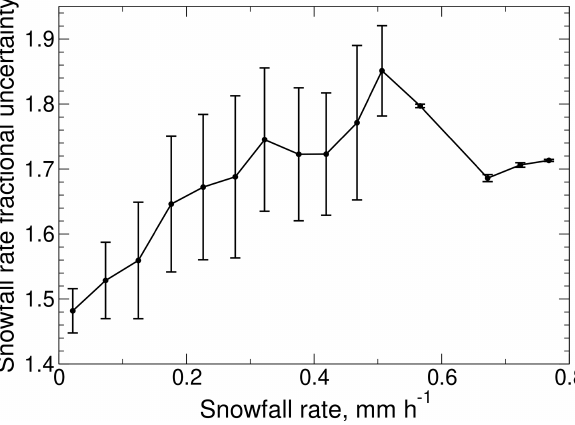
Figure 10. Instantaneous fractional uncertainties in snowfall rate. The central line shows mean fractional uncertainties and the error bars show ± 1 standard